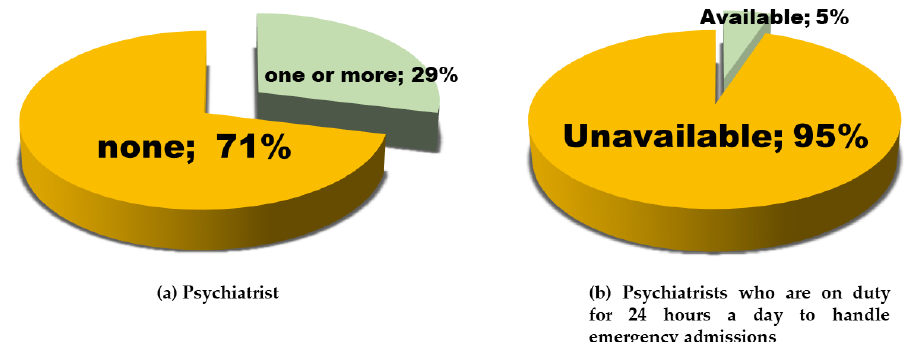
Figure 3. Multidisciplinary perinatal mental health care resources across different units: Maternal-fetal (MF) centers, general hospitals, and private clinics. ( a ) The distribution of psychiatrists. ( b ) The distribution of hospital social workers. ( c ) Experience of seamless multidisciplinary collaboration between medical units and community health centers.